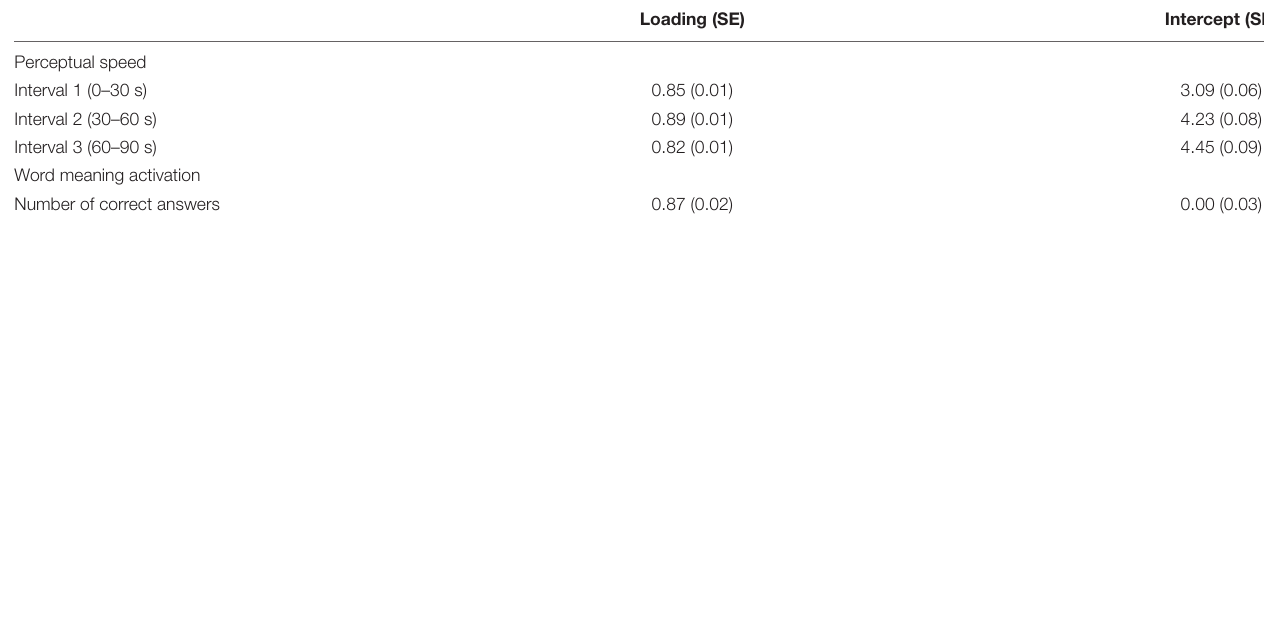
TABLE A3 | Measurement models perceptual speed and word meaning activation (standardized